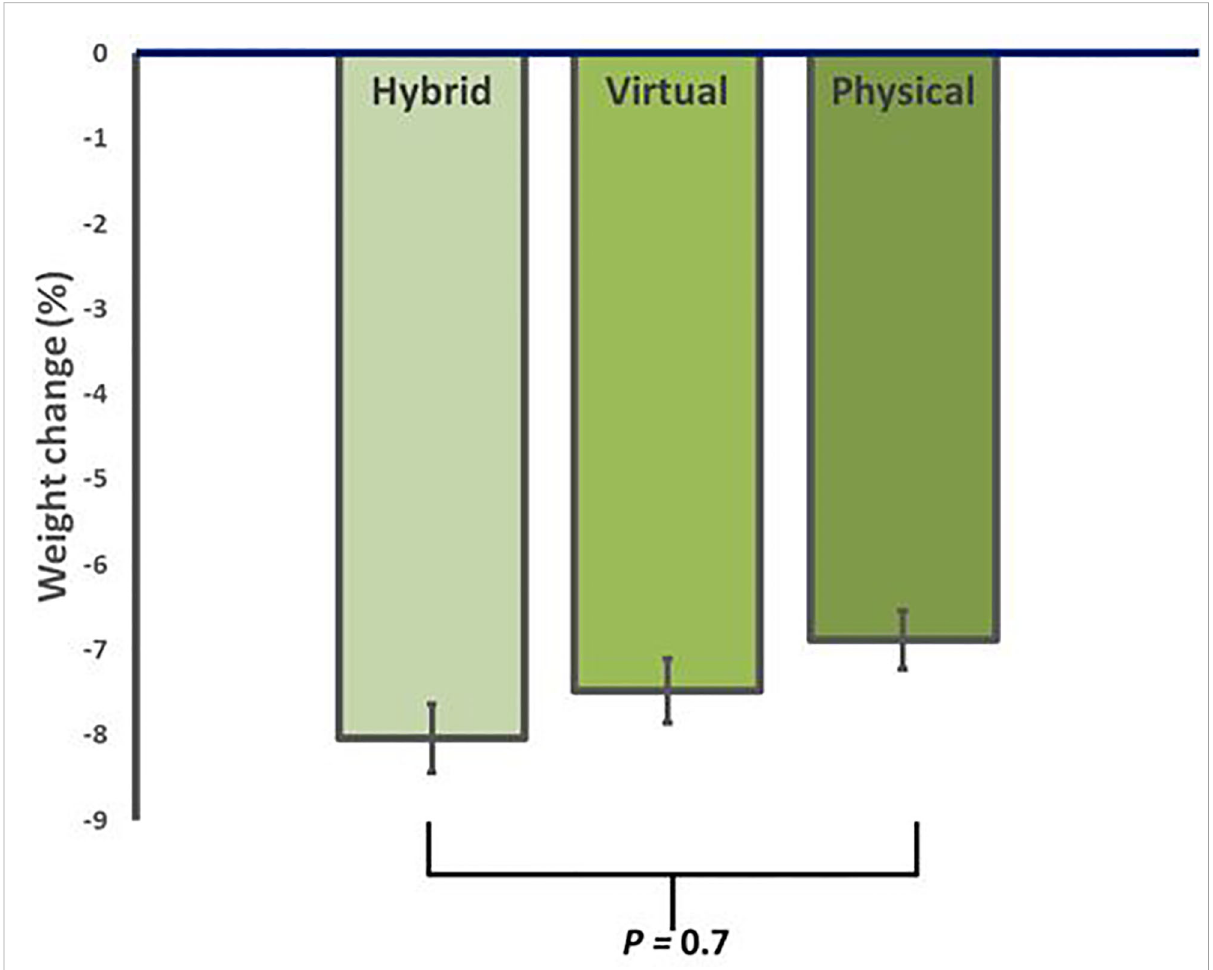
FIGURE 1 Average reduction in body weight for in-person (iPM), virtual (VM), and hybrid models (HM) after 12 weeks in a real-world intensive lifestyle intervention. All participants N = 56, iPM: n = 22, VM: n = 16, HM: n=18. p = change from baseline between iPM, VM, and